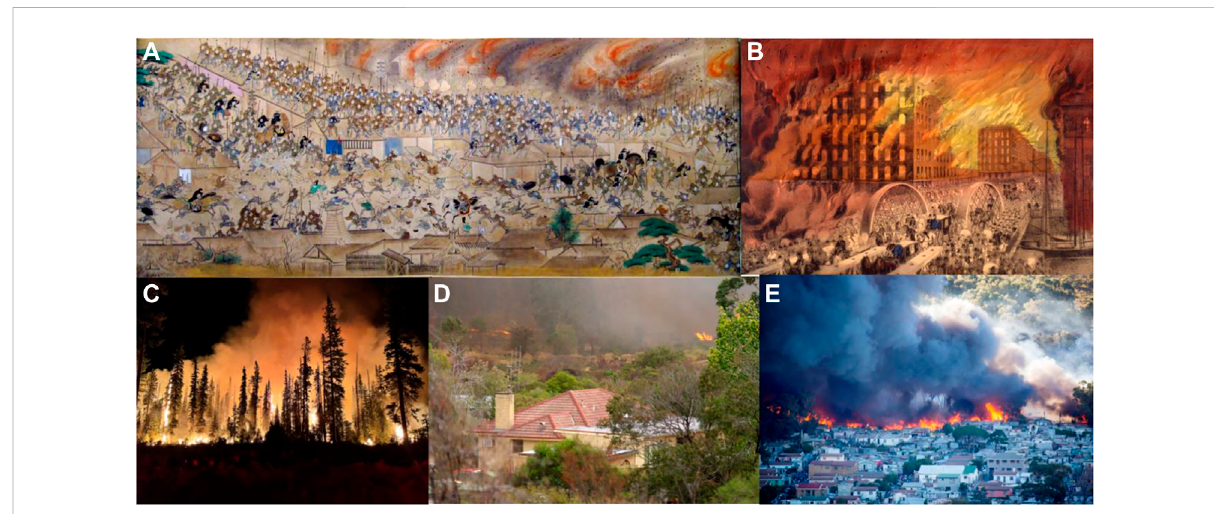
FIGURE 1 Great Meireki Fire of 1657, Japan (A) , Great Chicago Fire of 1872, United States (B) , Lick Creek Fire of 2021, Oregon, United States (C) , Black Saturday 2009, Australia (Attribution: Richmeister at English Wikipedia) (D) , and Imizamo Yothu Informal Settlement Fires of 2017, South Africa (Credit: Aletta Harrison/GroundUp) (E)